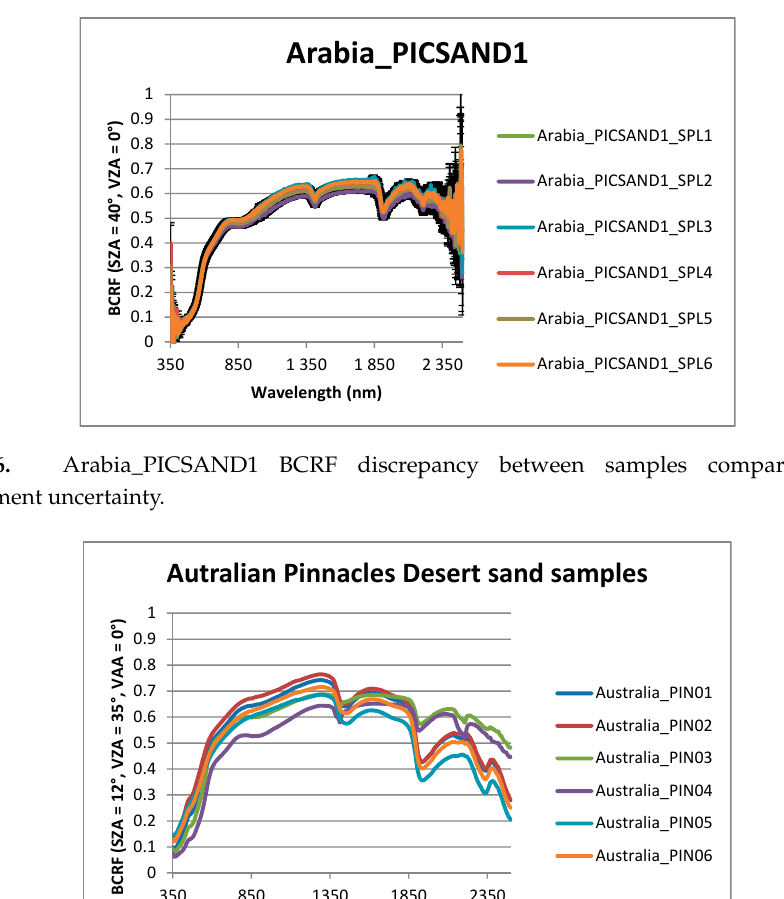
uncertainty . measurement uncertainty. Remote Sens. 2019 , 11 , 2446